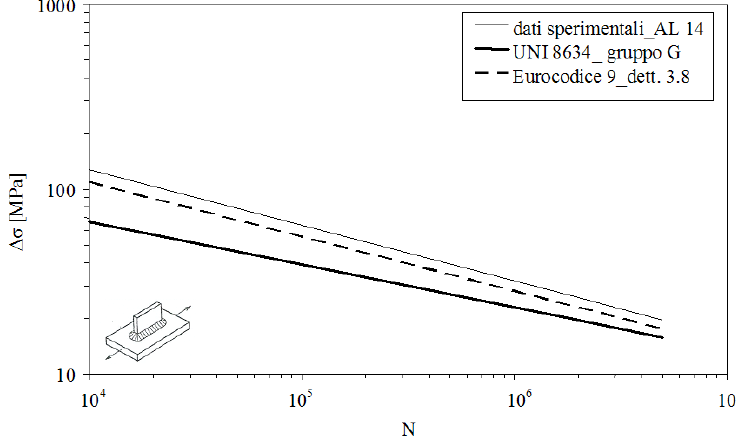
Figura 14: Confronto tra curva di resistenza a fatica per attacchi longitudinali.